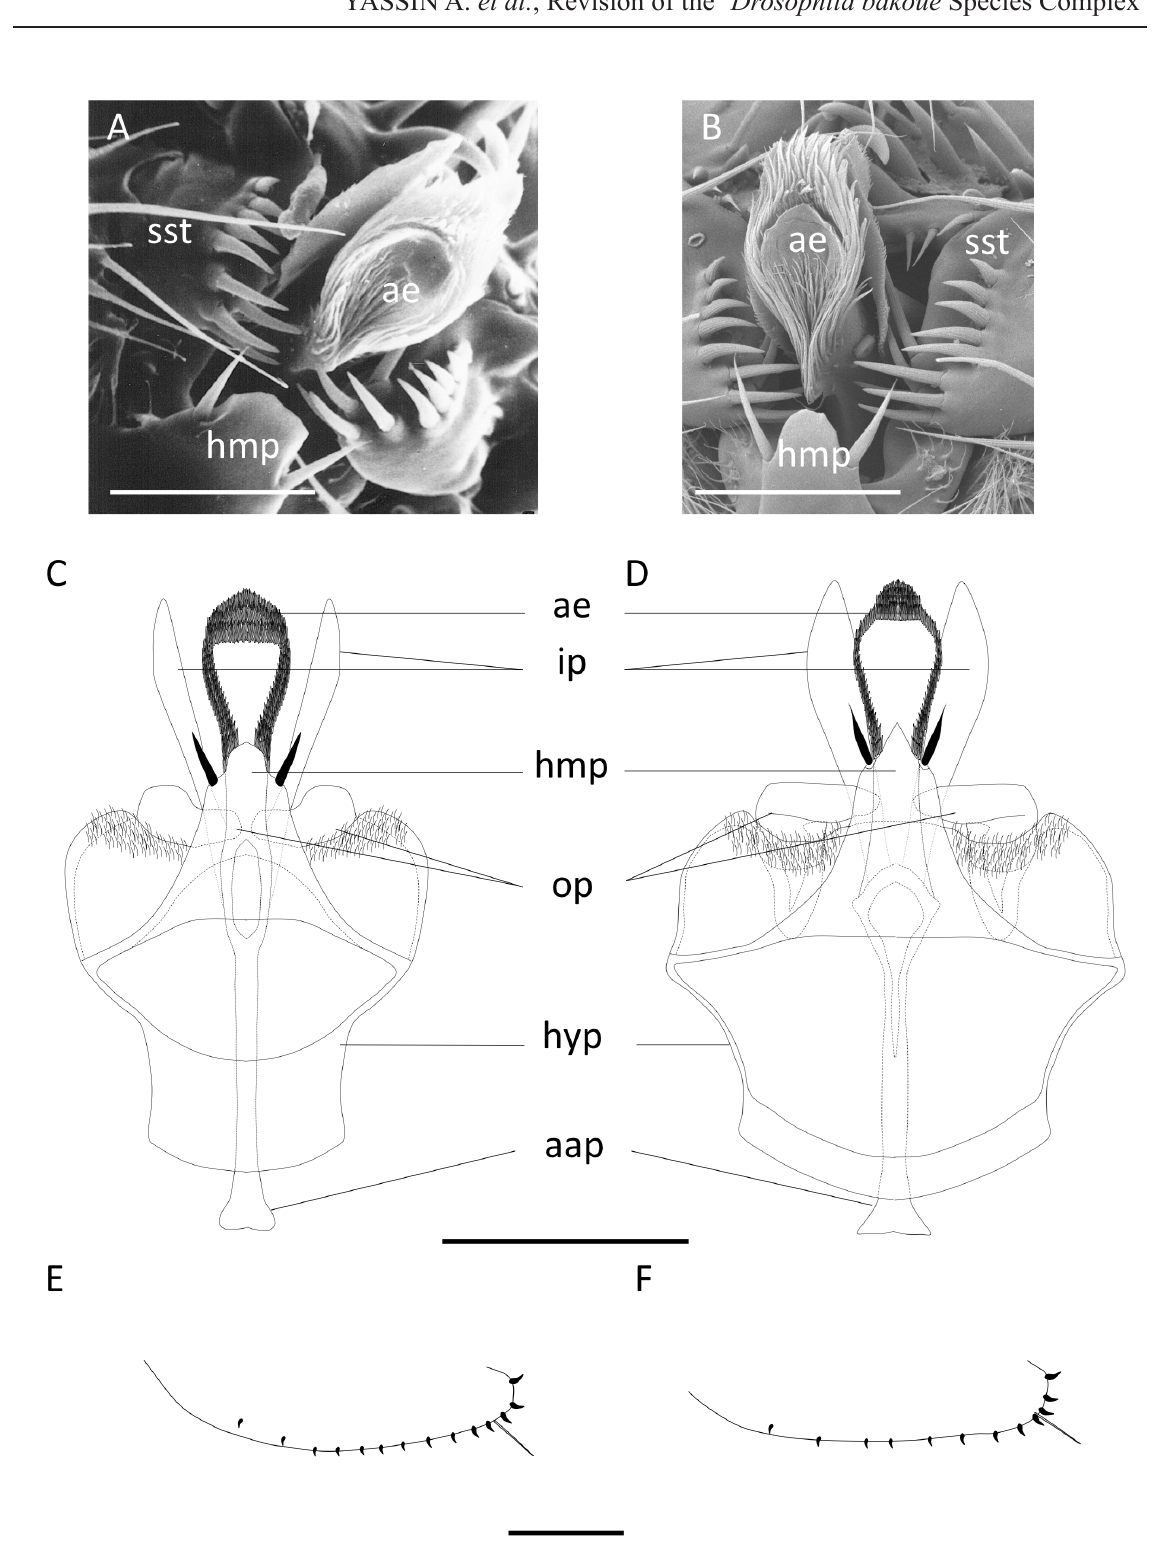
Fig. 9. Terminalia of the ‘ D. vulcana species complex’. A , C , E . D. vulcana Graber, 1957 (MNHN). A , C . ♂. E . ♀. B , D , F . D. mylenae David & Yassin sp. nov. (MNHN). B , D . ♂. F . ♀. Scale bars: A–B = 50 µm; D–F = 100